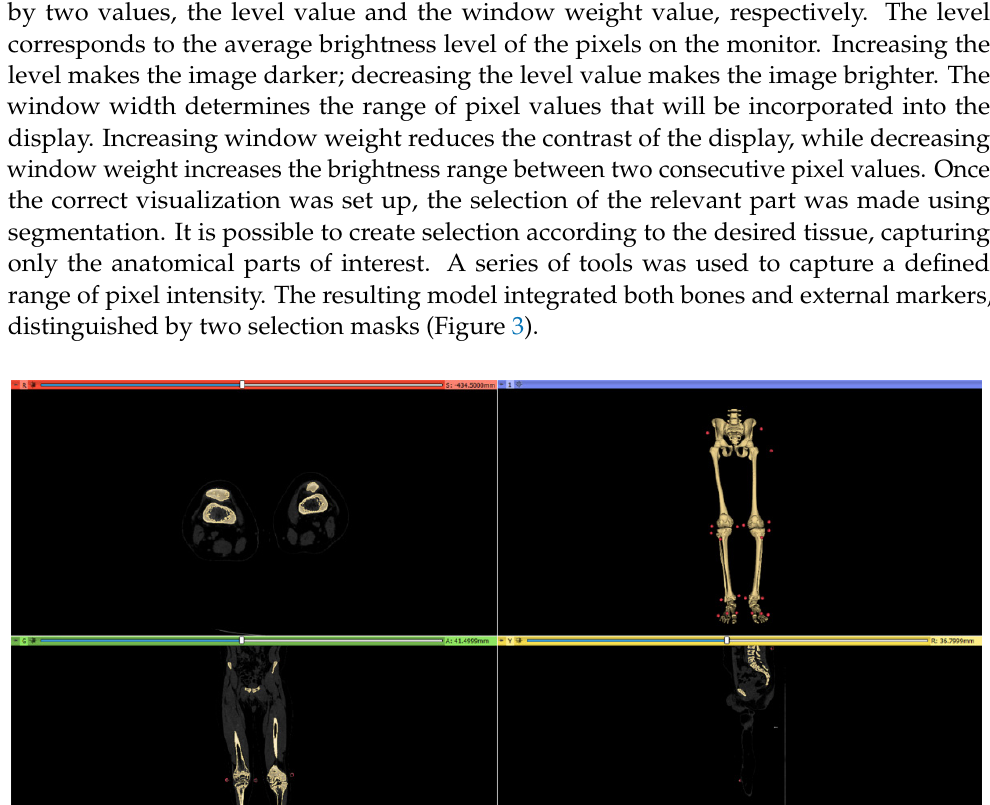
Figure 3. CT scan reconstruction using 3DSlicer. The brightness was set to 400 and contrast to 1000. For bone tissue reconstruction was selected a range of pixel intensity between 150 and 3264, while for the markers a range between 250 and 3264.